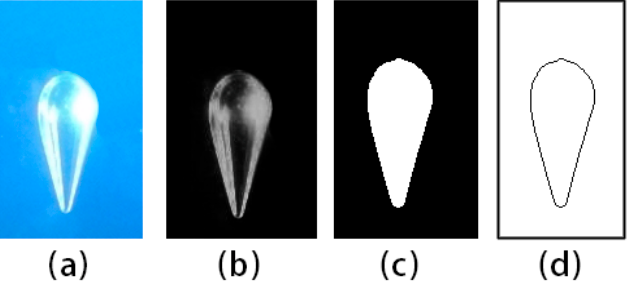
Figure 2. Steps of image processing: ( a ) initial image; ( b ) background division and binarization; ( c ) hole filling; ( d ) edge extraction.